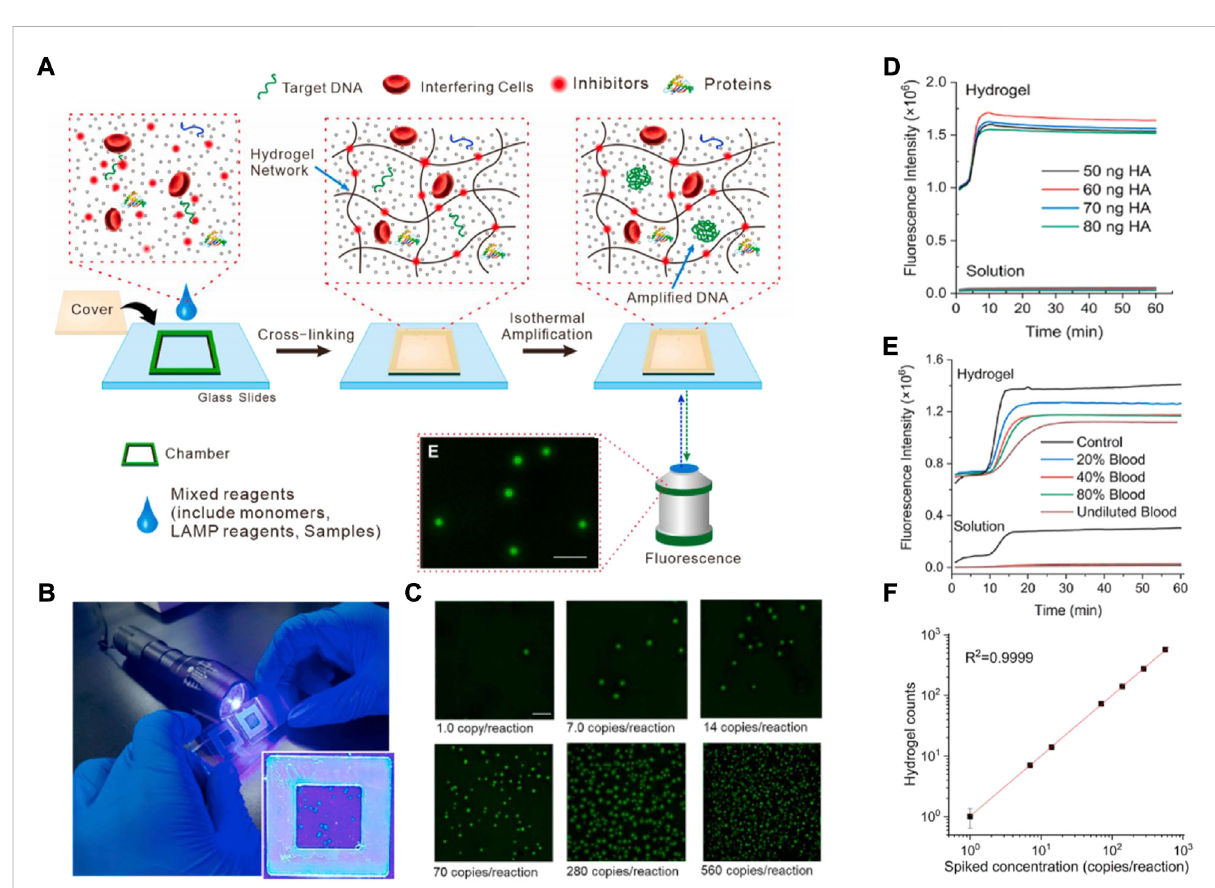
FIGURE 4 (A) Schematicillustrationofisothermal ampli fi cationinsidethenanoporoushydrogelfordigital LAMPincomplexmatrices. (B) Thephotograph for naked-eye counts of amplicon dots in the hydrogel under the LED fl ashlight. (C) Endpoint fl uorescence images of hydrogel after LAMP reaction for unprocessed wholebloodspiked with aseries concentration ofthe E.coli genome.Scale barof 1 mm. (D) The impact